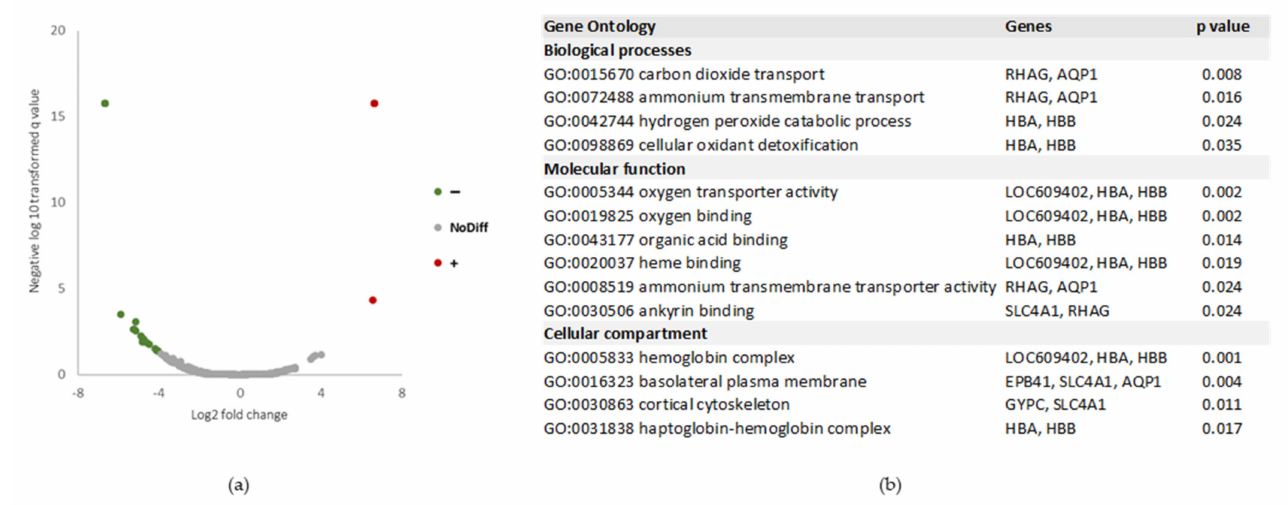
Figure 6. ( a ) Volcano plot representation of the abundance ratio of proteins present in CanL group versus Healthy group, represented in log 2 fold change values. The differentially abundant pro- teins ( p < 0.05) are represented by coloured dots. NoDiff—proteins with no altered abundance; “+”—proteins significantly more abundant in CanL group; “ − “—proteins significantly less abundant in CanL group. ( b ) GO enrichment analysis shows terms for biological processes, molecular function and cellular composition significantly overrepresented in the proteins significantly less abundant in CanL